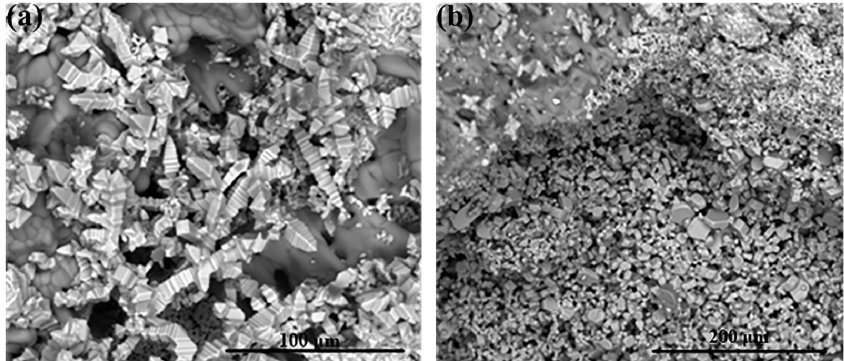
Figure 9. Energy ‐ dispersive X ‐ ray spectroscopy (EDS) analysis after corrosion of TiB 2 coating sur ‐ face. 3.6. Analysis of Dynamic Corrosion Results of TiB 2 Coating Figure 10 is a cross ‐ sectional view of the TiB 2 coating after dynamic corrosion, and Figure 11 is the cross section of the TiB 2 coating after the dynamic corrosion experiment and the EDS energy spectrum of points taken near the TiB 2 coating surface. Figure 10. The section after the corrosion of the TiB 2 coating.( a ) Low ‐ magnification figure and ( b ) Micro ‐ topography